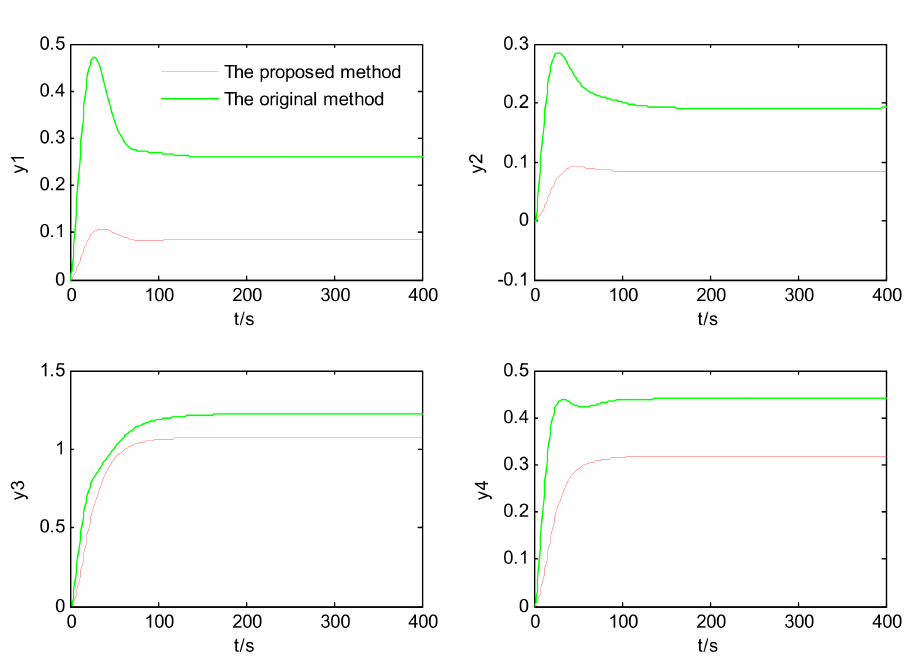
Figure 6. Set-point responses of r 3 = 1 and r 1 = r 2 = r 4 =